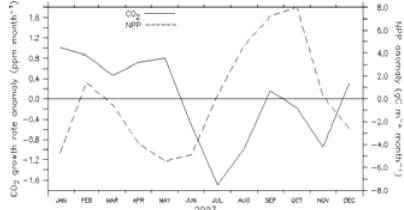
Figure 4 CO 2 growth rate anomaly compares with anomaly of NPP over India during the climatological year.